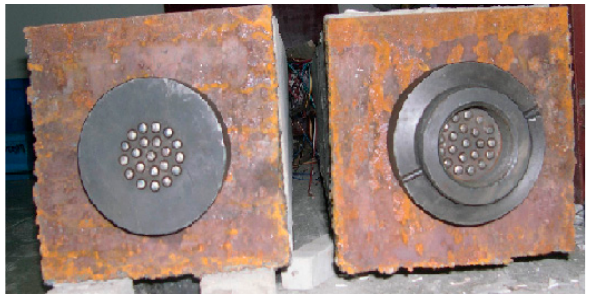
Figure 1. Prestressed concrete “series connected” creep specimens.